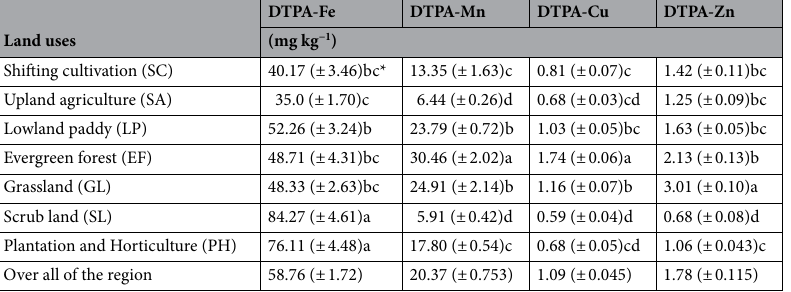
Table 3. Measured DTPA-extractable micronutrient contents (without outliers) under major land use systems in the soils of NEI. *Means in the column followed by different letters (a-d) are statistically significant at 5% level of